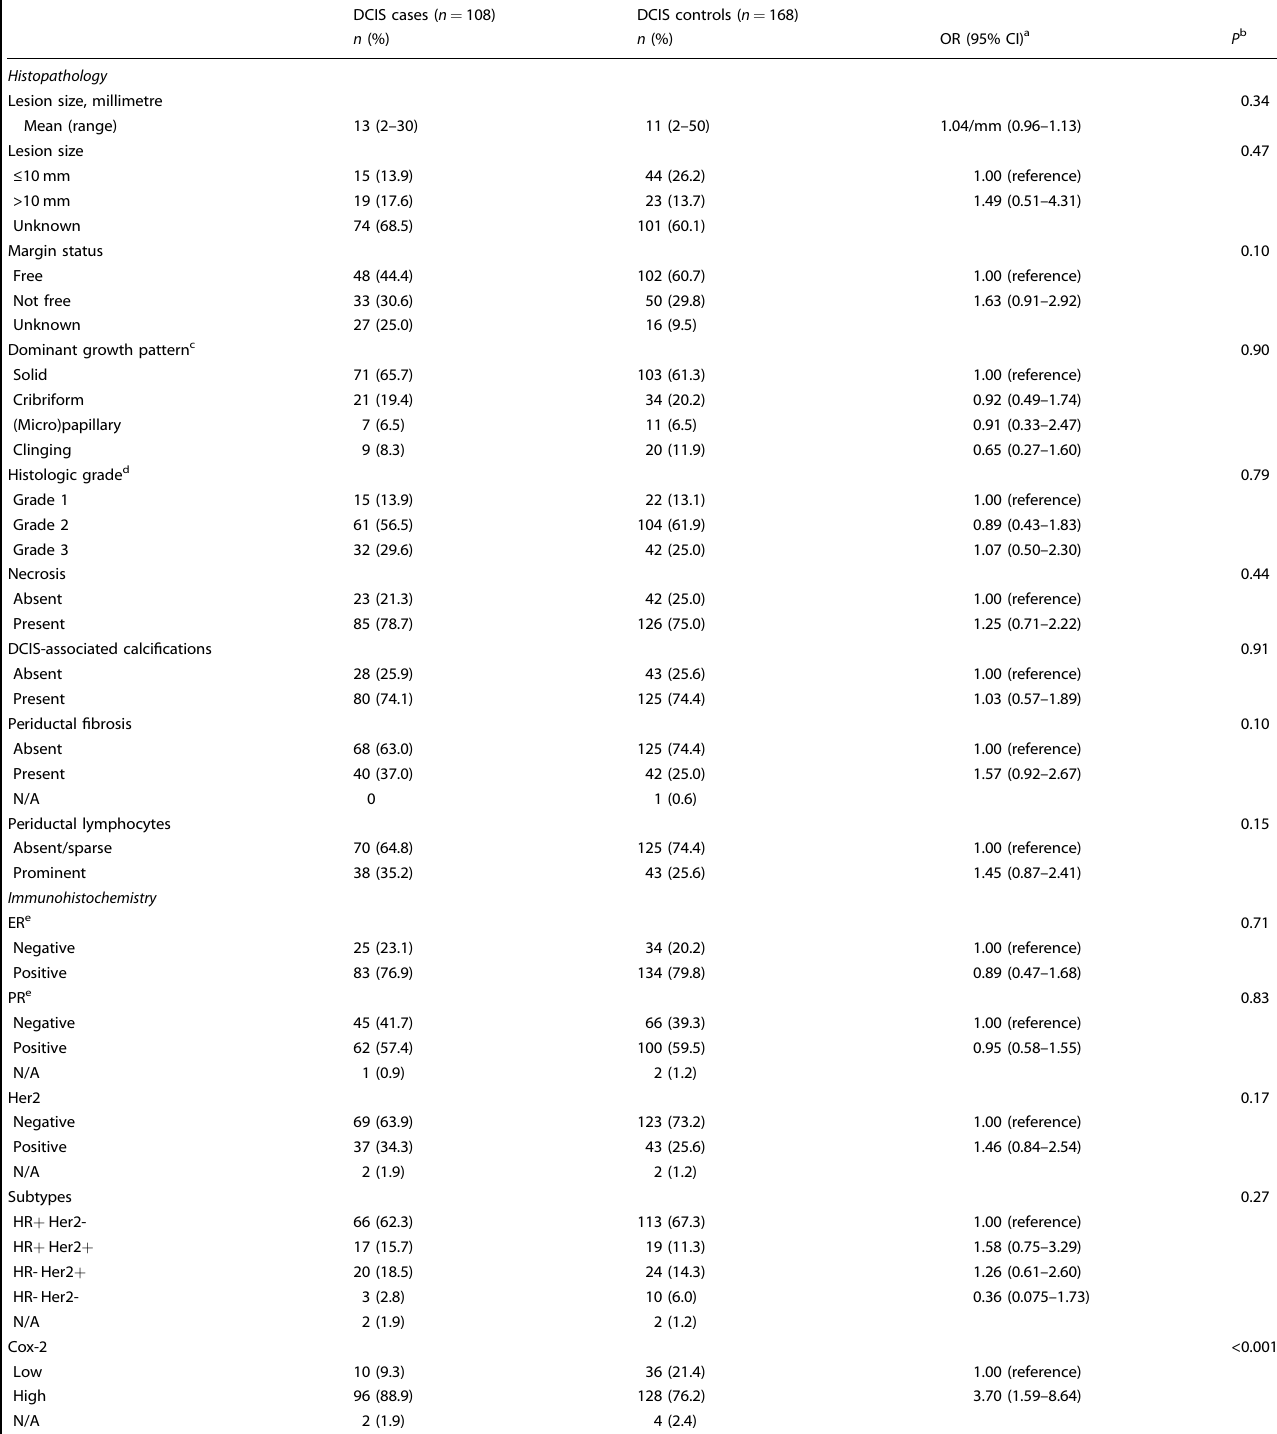
Table 2. Univariate results of histopathological characteristics and IHC markers associated with subsequent